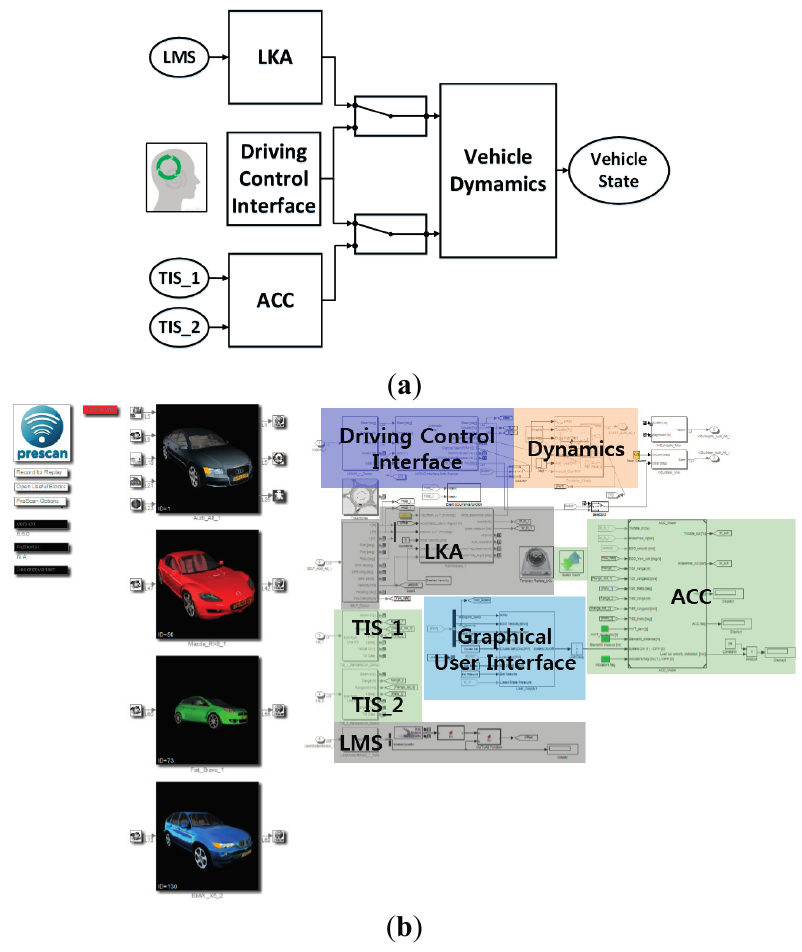
Figure 9. Overall system architecture of the simulated vehicle equipped with the ACC system: ( a ) system diagram; and ( b ) implementation using MATLAB and Simulink in